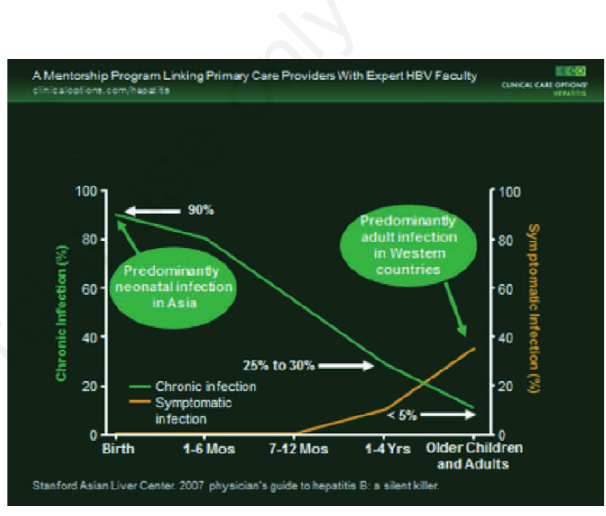
Figure 2. Outcome of HBV infection by age of transmission.